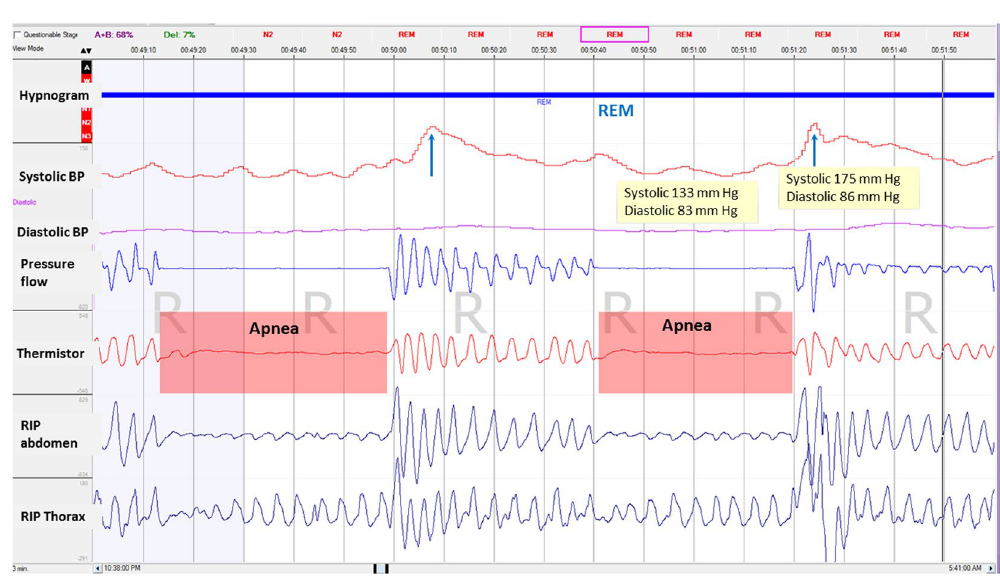
Figure 2. A zoomed epoch of 6 minutes during REM sleep showing an increase in blood pressure in the post- obstructive event period (blue arrows). REM: rapid eye movement.